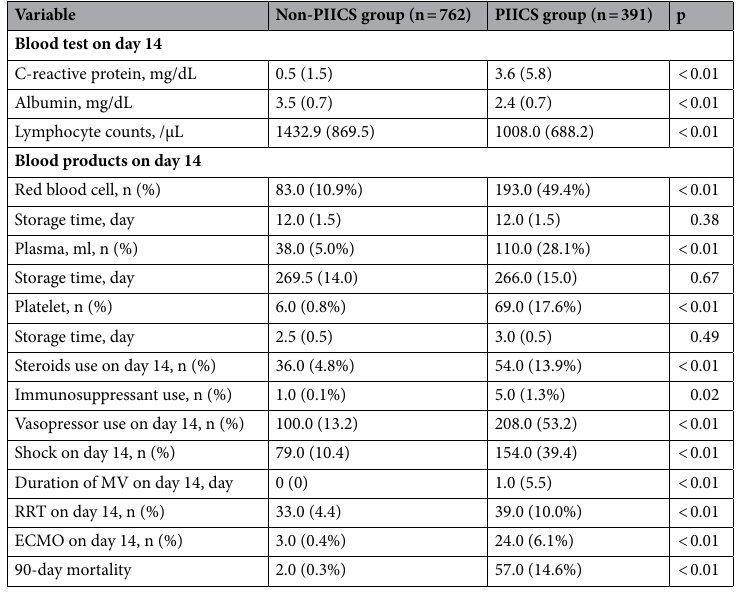
Table 2. Variables on day 14 and outcomes. PIICS persistent inflammation, immunosuppression, and catabolism syndrome, MV mechanical ventilation, RRT renal replacement therapy, ECMO extracorporeal membrane oxygenation.